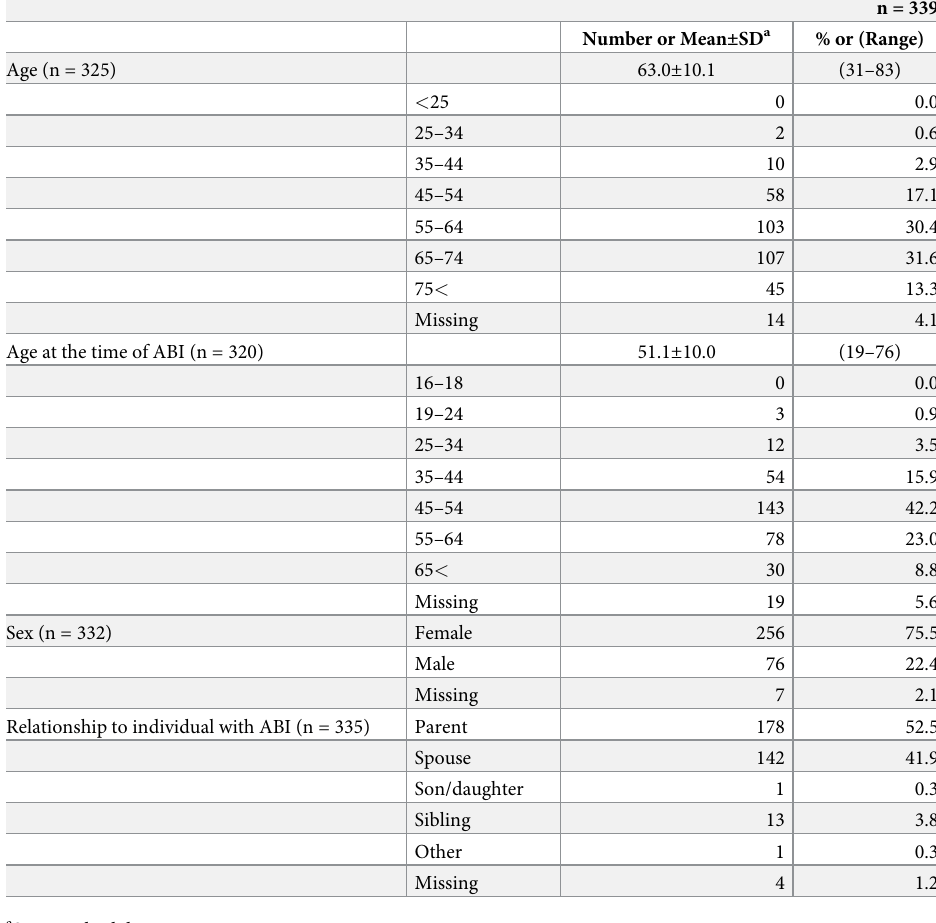
Table 1. Demographic characteristics of family